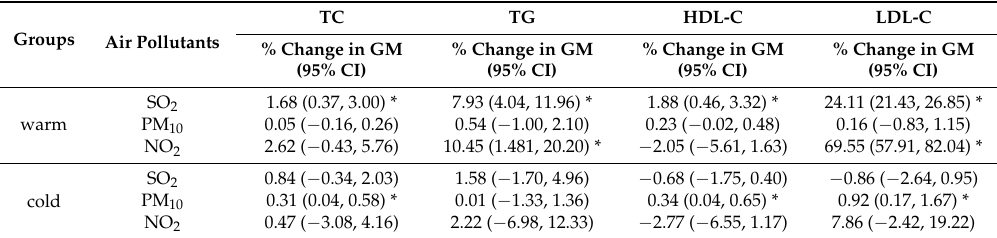
Table 4. Percent change in GM of TC, TG, HDL-C and LDL-C per 10 µ g/m 3 increase in air pollutants among type 2 diabetes patients in different